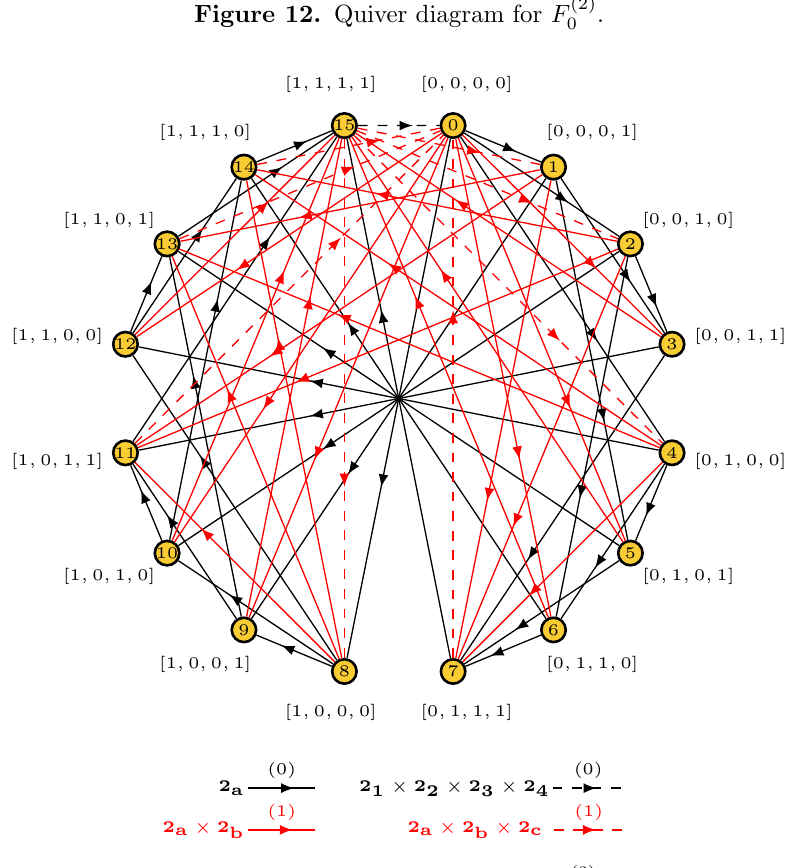
(c) Quiver for F (3) Figure 13. Quiver diagram for F (3)